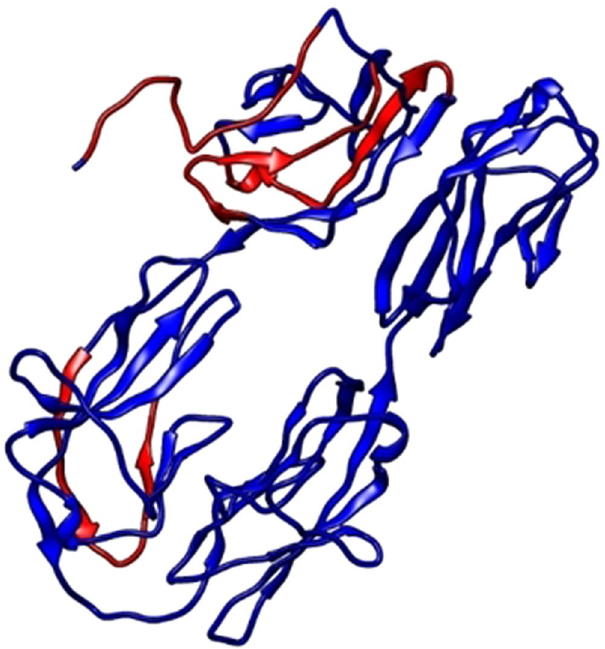
Figure 2. IFN γ epitope prediction, linear IFN γ epitope have been shown in red color in carrier